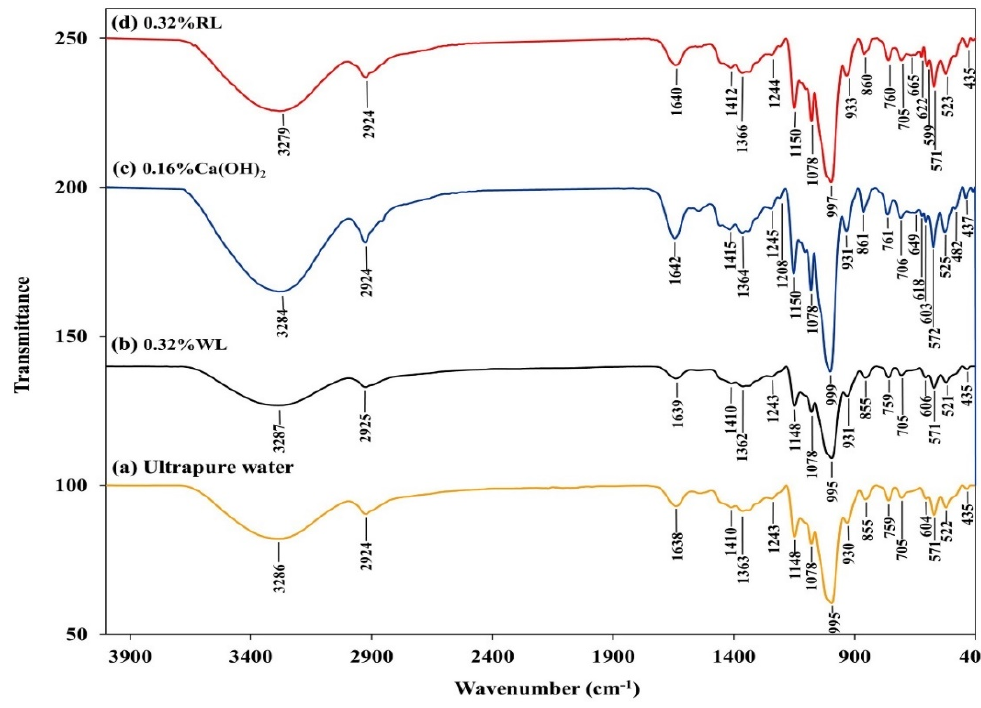
Figure 6. FTIR spectra of the cryogels.